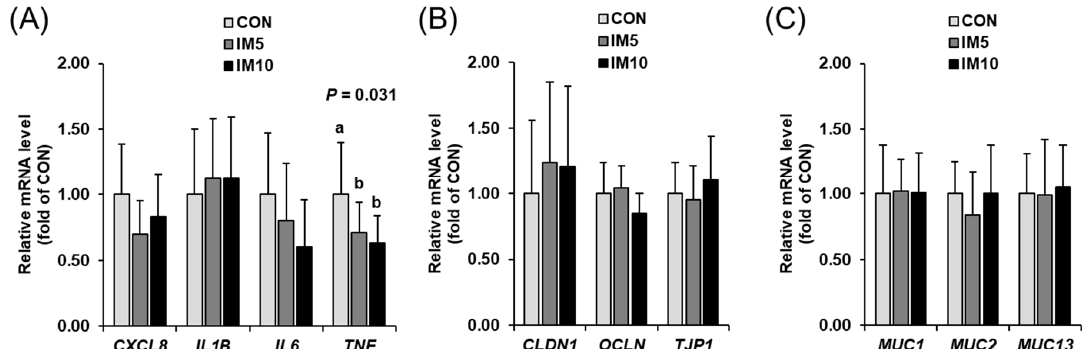
Figure 7. Relative mRNA levels of genes encoding inflammatory mediators (( A ): C-X-C motif chemokine ligand 8 ( CXCL8 ), interleukin 1 beta ( IL1B ), IL6 , and tumor necrosis factor ( TNF )), tight junction proteins (( B ): claudin 1 ( CLDN1 ), occludin ( OCLN ) and tight junction protein 1 ( TJP1 )), and mucins (( C ): mucin 1, cell surface-associated ( MUC1 ), mucin 13, cell surface-associated ( MUC13 ) and mucin 2, oligomeric mucus / gel-forming ( MUC2 )) in ileal mucosa of pigs fed isonitrogenous diets without (CON) or with 5% (IM5) or 10% Tenebrio molitor larvae meal (IM10) for four weeks. Bars are means ± SD for n = 10 pigs per group. Relative mRNA levels are expressed as fold of group CON ( = 1.0). a,b Values with different superscripts differ significantly at p < 0.05.